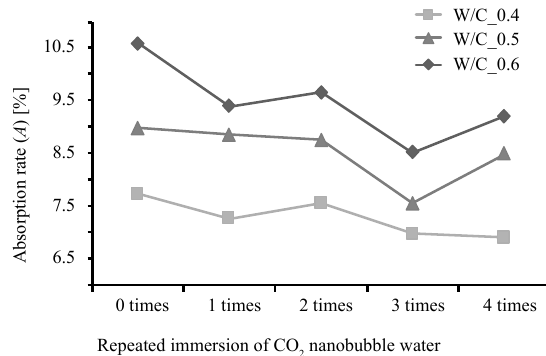
Figure 4. Relationship between number of immersions and rate of water absorption. Figure 3. Relationship between number of immersions and absolute dry density.